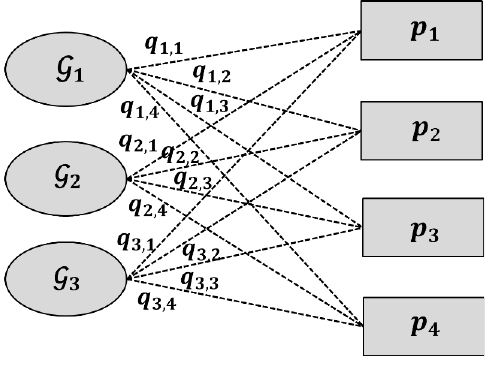
Figure 4. Matching groups to